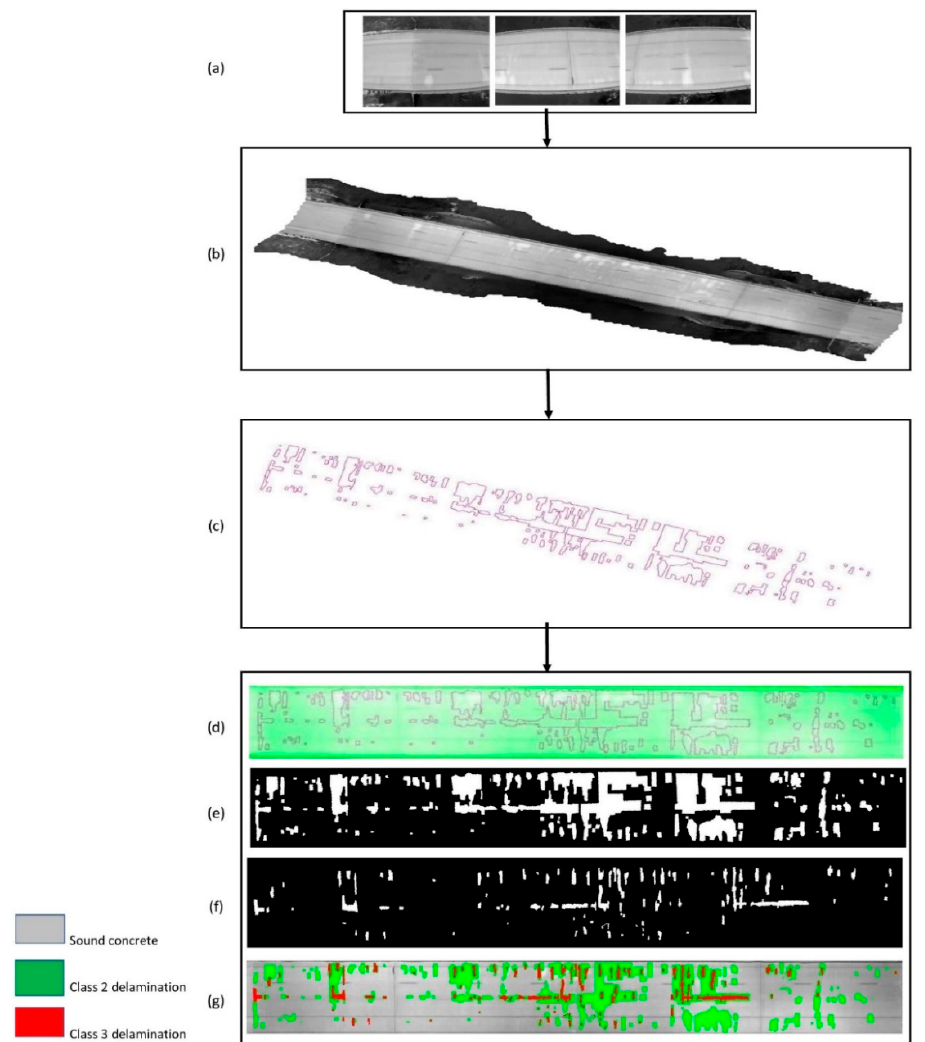
Figure 10. Workflow for annotation ( a ) raw images inputs for stitching ( b ) stitched image ( c ) ground truth survey map for class 2 ( d ) aligned and registered ground truth ( e , f ) binarized images for class 2 and 3 delamination, and ( g ) Annotated pixels. Table 9. Summary of Affine transformation tuned parameters for registration. Bridge